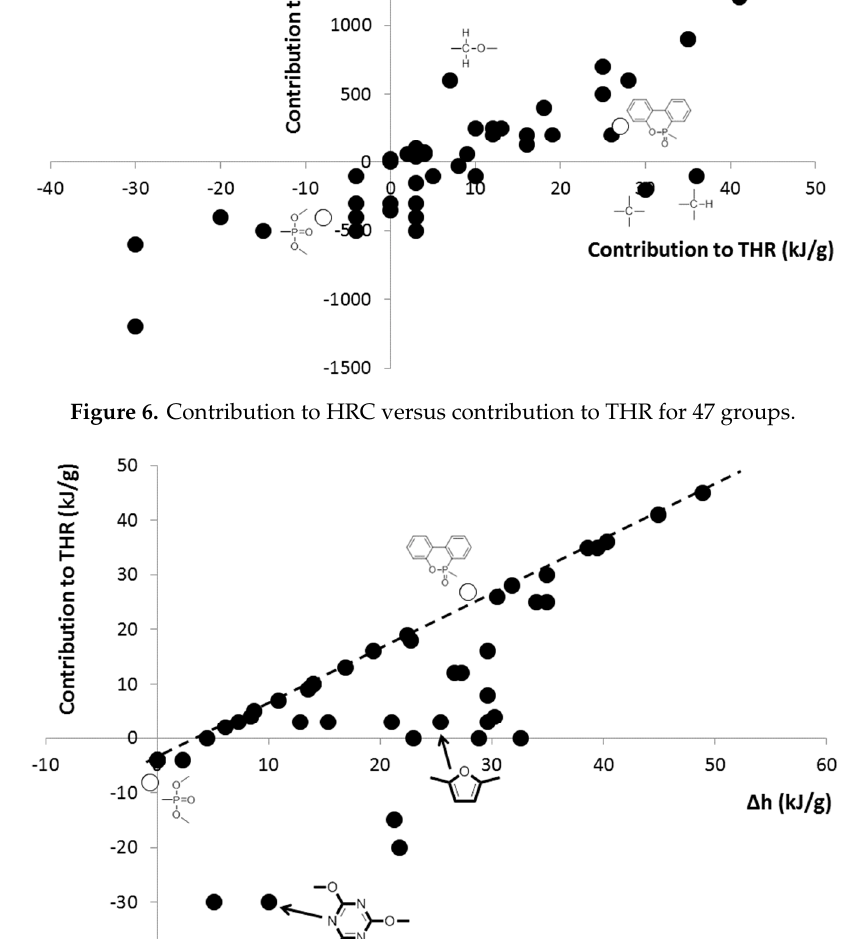
Figure 6. Contribution to HRC versus contribution to THR for 47 groups.